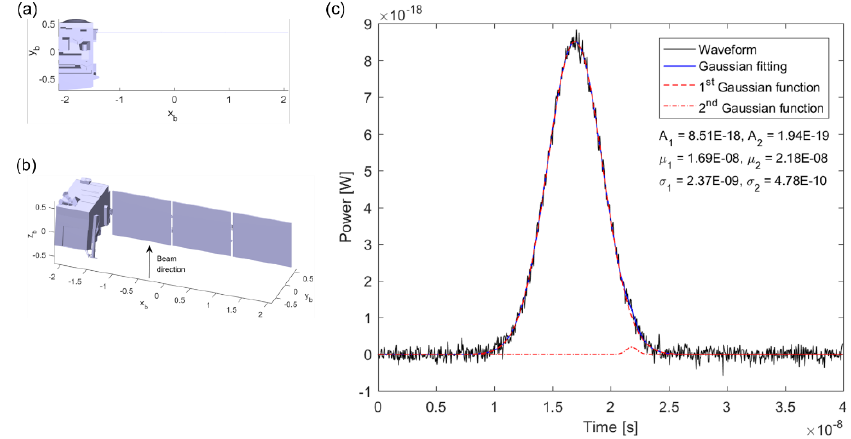
Figure 7. The ( a ) reflected surface, ( b ) orientation of defunct satellite, and ( c ) the echo waveform and 2 Gaussian functions obtained from the Gaussian decomposition for -90° rotation about the x-axis w.r.t. Figure 2a.